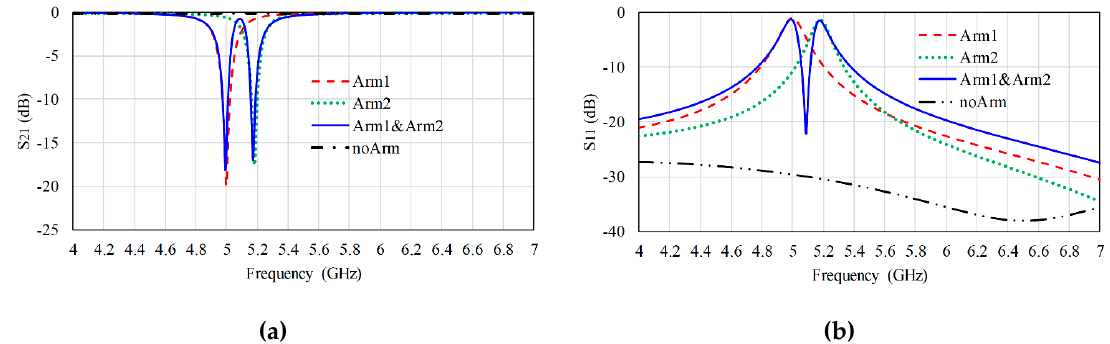
Figure 6. S 21 ( a ) and S 11 ( b ) responses for the single quad-state microstrip resonator.